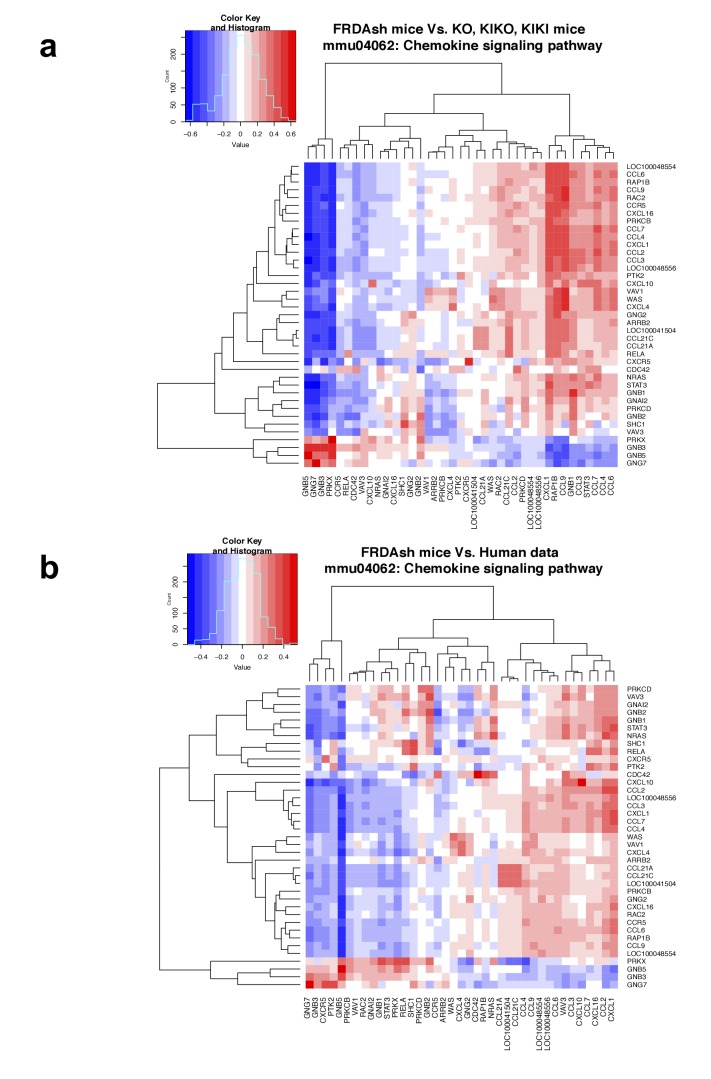
Chemokine signaling pathway is altered in FRDA patients and mouse models.(a–b) Correlation heatmap between gene expression levels (in fold induction over controls) of FRDA knockdown mice and other mouse models (a) and FRDA patients (b) in chemokine signaling pathway genes. Positive correlations are marked in red and negative ones in blue (see legend).